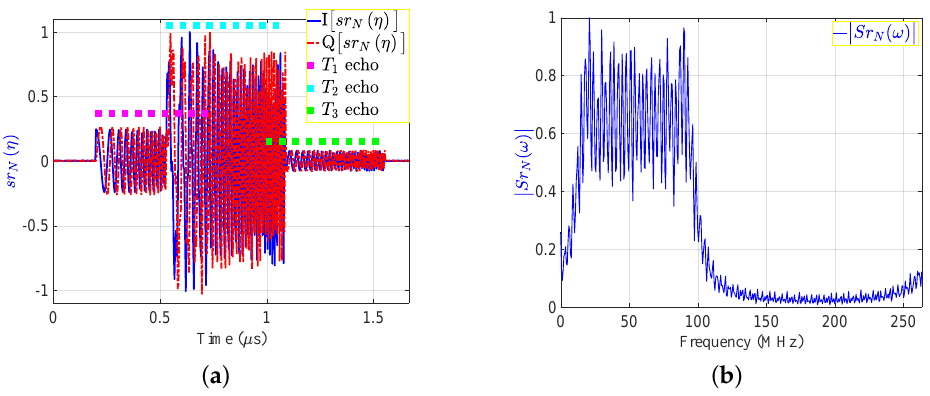
(cid:12) (cid:1)(cid:12) (cid:0) Figure 6. The received signal in time and frequency domains: ( a ) sr N ( η ) ; ( b ) ω (cid:12) Sr N (cid:12) . (cid:0) (cid:1) ω is then multiplied by the received 7. The conjugate of the transmitted signal S ∗ N (cid:0) (cid:1) (cid:0) (cid:1) ω ω signal, Sr N , to get the correlation signal in frequency domain, Xr N : (cid:0) (cid:1) = (cid:2) (cid:0) (cid:1) (cid:0) − (cid:1) + (cid:0) (cid:1) (cid:0) − (cid:1) Xr N A r S N j ω n d A r S N j ω n d ω ω ω exp exp 2 1 2 1